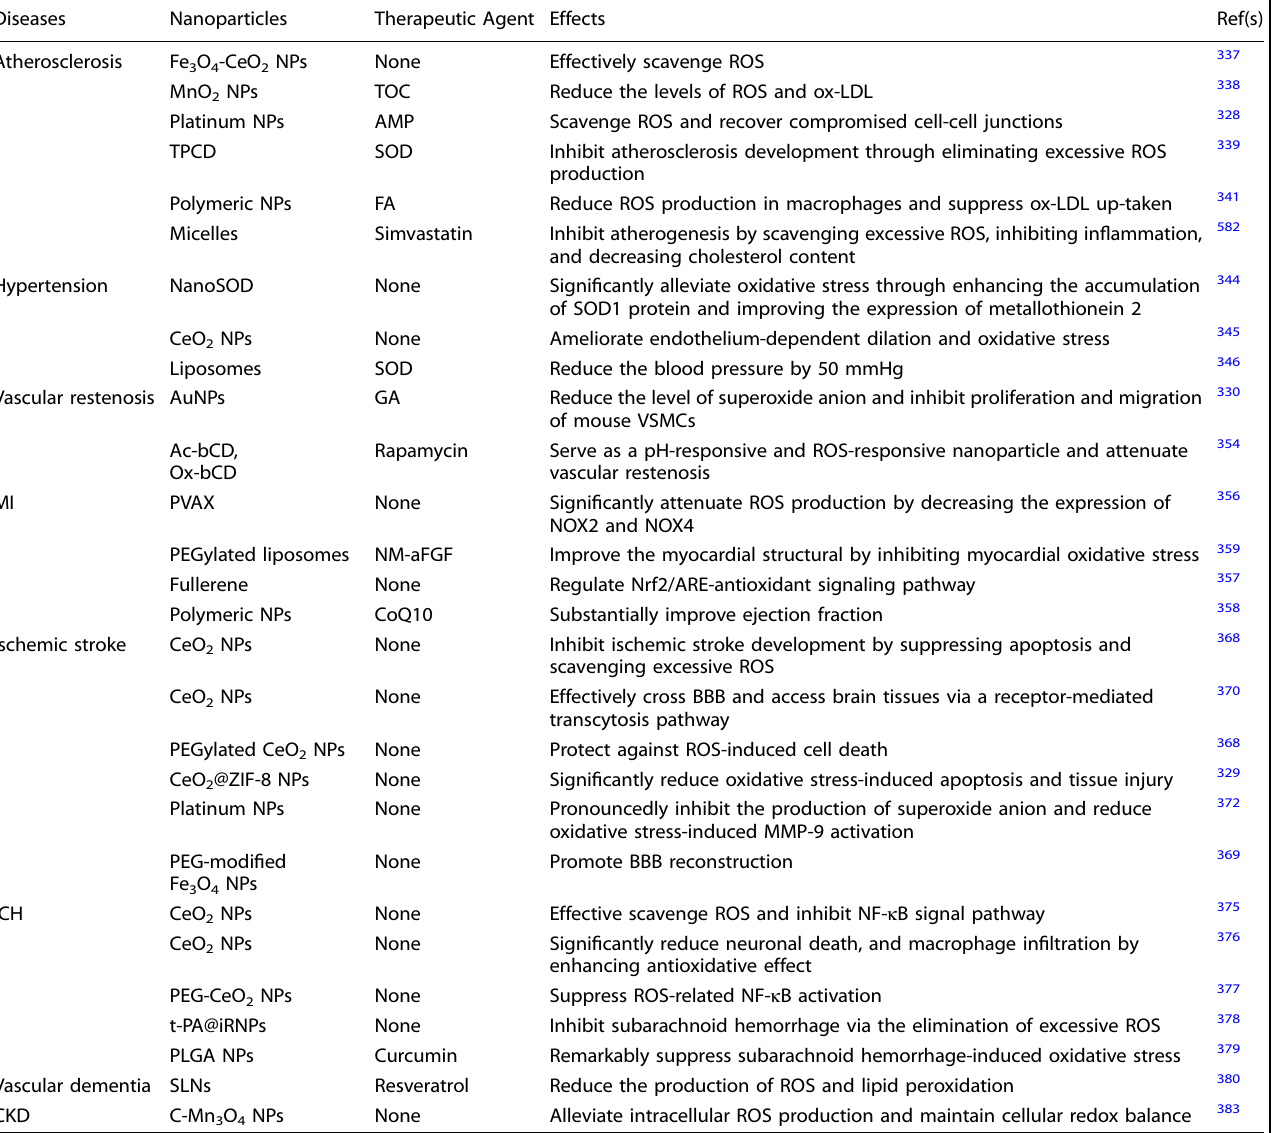
Table 3. Nanoparticles-mediate anti-oxidative therapies for vascular aging-related diseases